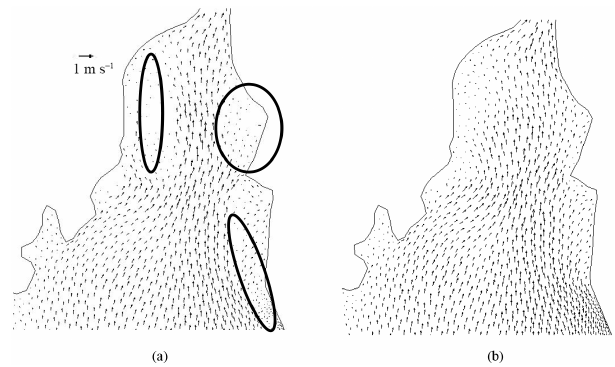
Figure 15. Flow structure of Pink Beach in vegetated (a) and non- vegetated (b) areas. The black ellipses represent vegetated